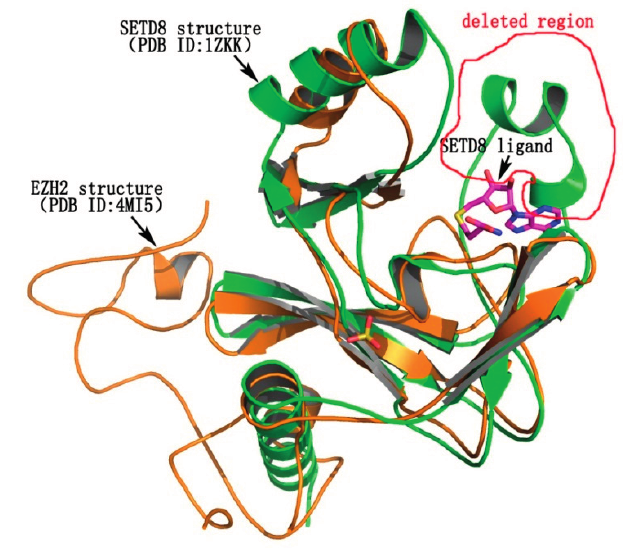
Figure 4. The homology of EZH2 (PDB ID: 4MI5) and SETD8 (PDB ID: 1ZKK). EZH2 is shown in yellow, while SETD8 is shown in green. The deleted region in the active binding pocket of EZH2 is circled in